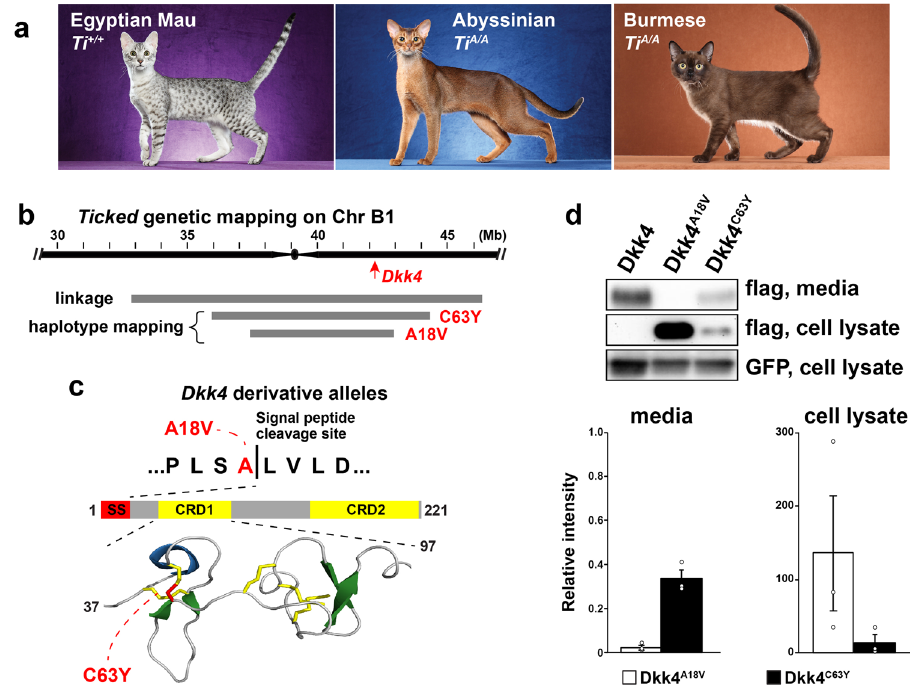
Fig. 5 Dkk4 mutations in Ticked cats. a Cat breeds selected for Spotted (Egyptian Mau) or for Ticked (Abyssinian and Burmese) color patterns, along with their inferred Ticked genotypes. Images from Helmi Flick, with permission. b Ticked genetic interval delineated by linkage 19 or shared haplotypes among cats with Dkk4 mutations. Coordinates are based on the felCat9 assembly. c Dkk4 coding mutations (red) at the signal peptide cleavage site (p.Ala18Val) or a cysteine residue (p.Cys63Tyr) involved in disul fi de bridge and cysteine knot formation within cysteine-rich domain 1 (CRD1). d Representative Western blot and quantitation of variant Dkk4 proteins produced by HEK293 cells 48 h after transfection. Dkk4 proteins are detected with an anti-FLAG antibody; co-transfection with a GFP-expressing plasmid and subsequent detection of GFP provides a control for transfection ef fi ciency. Relative intensity on the y - axis refers to the ratio of the Dkk4 band to GFP band intensity, normalized to non-mutant Dkk4; thus non-mutant Dkk4 relative intensity = 1.0 for both media and cell lysate. The experiment was repeated three times (mean + / − sem, one-way ANOVA, F = 515.2, P = 1.94 × 10 − 7 for media).